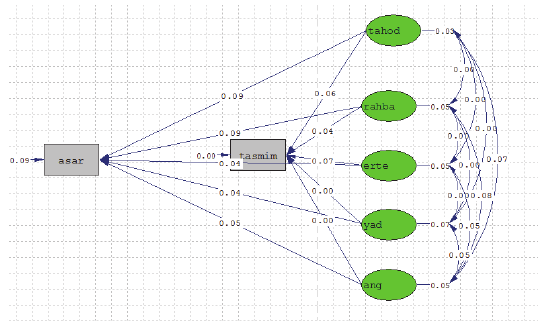
Fig. 3. Second order confirmatory factor analysis model after correction in significant case (t-